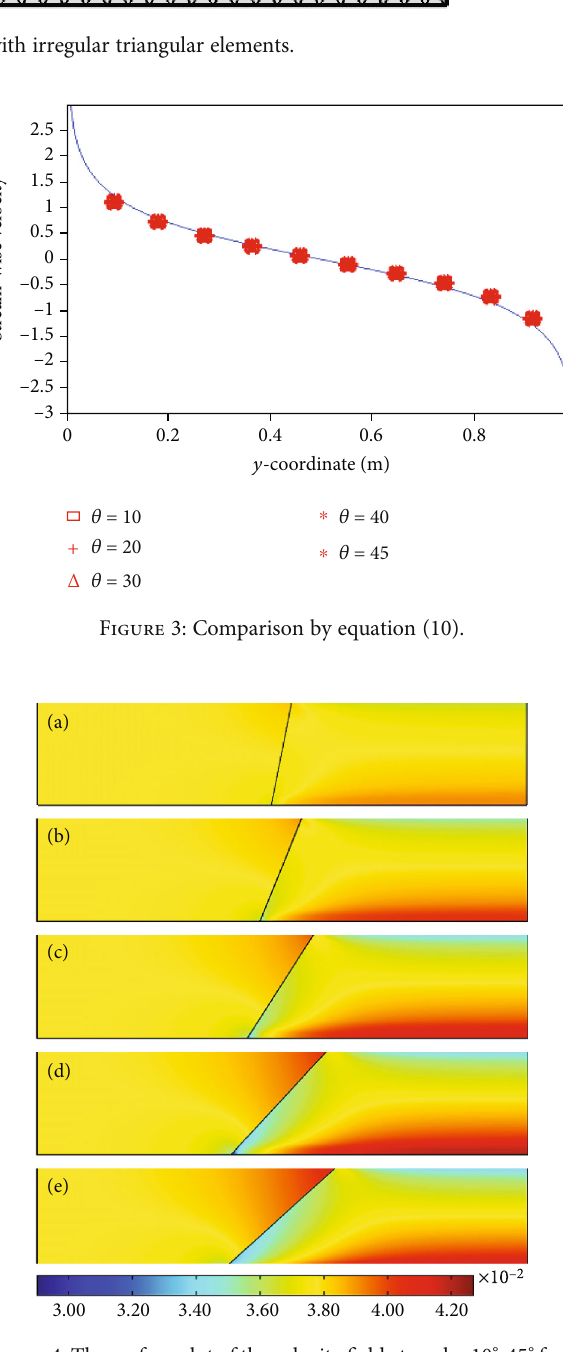
Figure 4: The surface plot of the velocity fi eld at angles 10 ° -45 ° from (a –